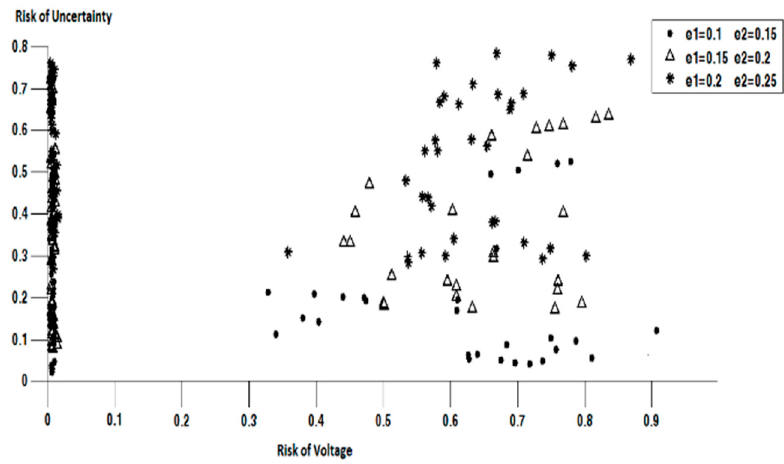
Figure 13. Two-dimensional diagram of instability risk and voltage risk in different experiments.